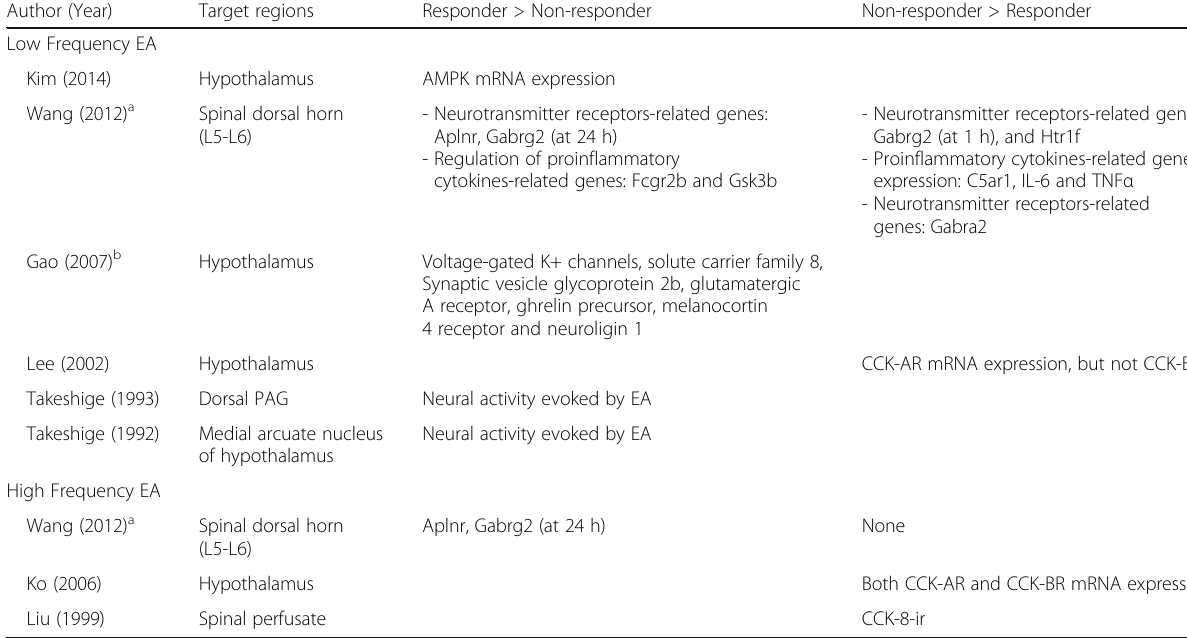
Table 4 Differentially expressed or changed factors between responder and non-responder Author